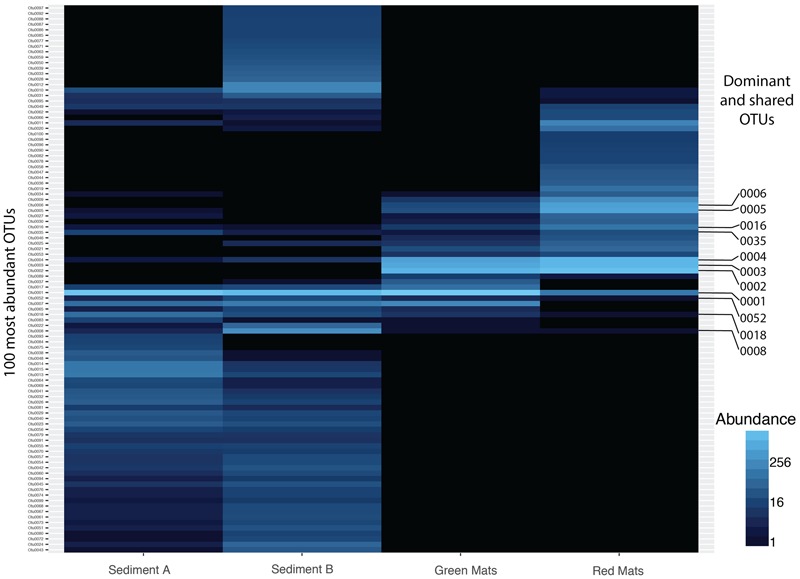
Heatmap illustrating the abundance of the top 50 OTUs across all samples. 7 OTUs are shared across all samples. Dominant (OTU 0001, 0002, 0003, 0004, 0005, 0006) and shared OTUs (0001, 0004, 0008, 0016, 0018, 0035, 0052) are labeled and presented in Tables 2, 3.